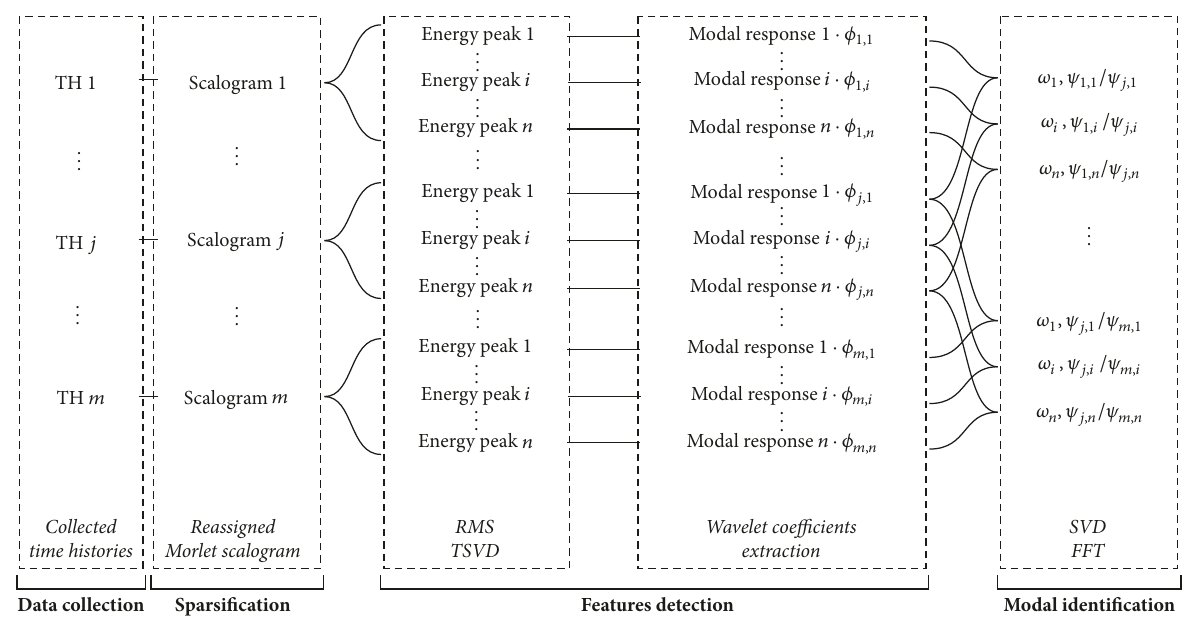
Figure 3: Workflow of the identification